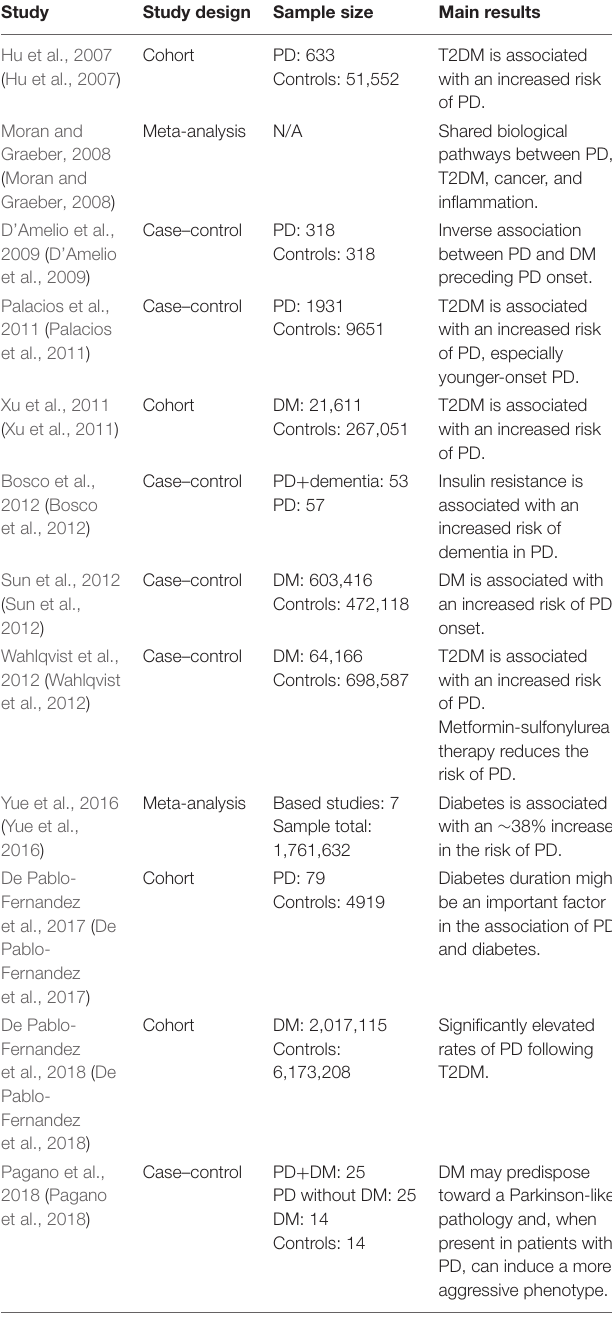
TABLE 2 | Recent studies on the correlation between diabetes mellitus (DM) and Parkinson’s disease (PD).